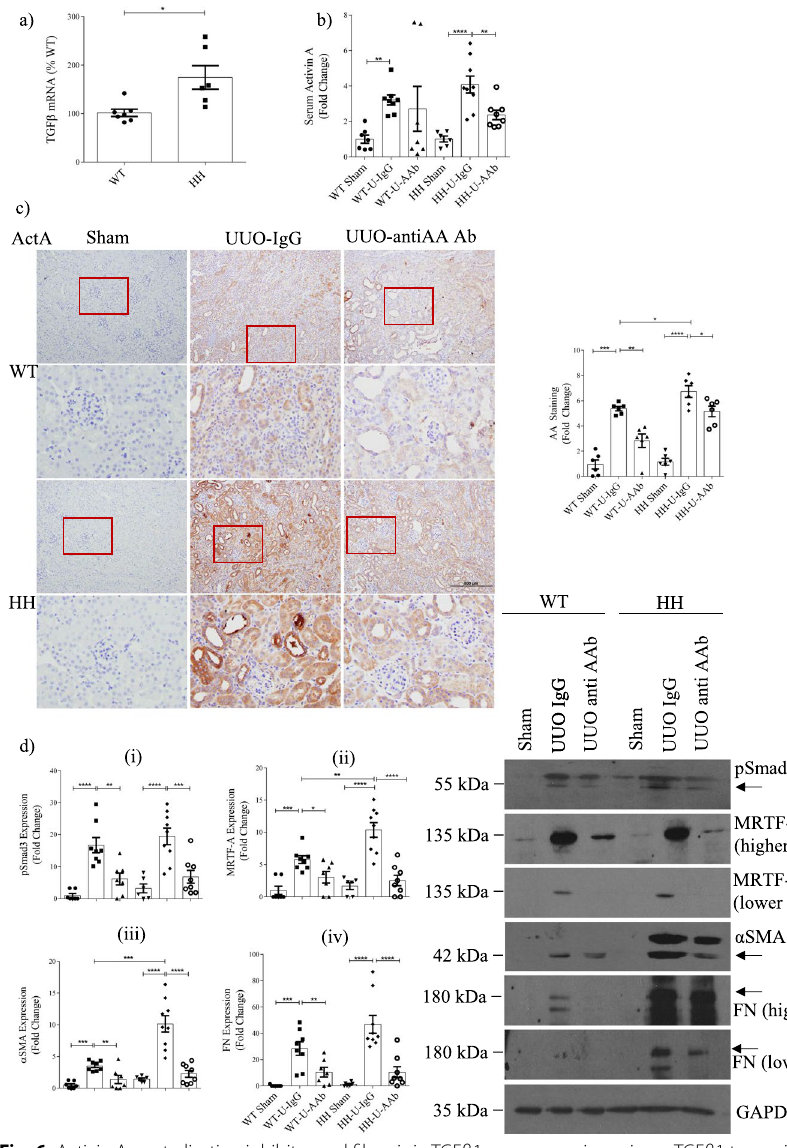
Fig. 6 Activin A neutralization inhibits renal fibrosis in TGFβ1-overexpressing mice. a TGFβ1 transcript is increased in mice genetically engineered to overexpress TGFβ1 (HH) compared with wild-type mice (WT) (n 6–7, *p 0.05). b Serum actA is elevated in wild-type and HH mice after UUO. This is decreased by = ≤ treatment with a neutralizing actA antibody (anti-actA) in HH mice. c Renal actA is increased after UUO, with a greater induction in HH mice. Both are attenuated by actA neutralization. Boxed areas are shown at higher magnification immediately below. ActA increases are seen particularly in tubular epithelial cells. d Renal αSMA, fibronectin (FN), pSmad3 and MRTF-A are increased after UUO and this is augmented in HH kidneys. Expression of all is attenuated by actA neutralization in both WT and HH kidneys.